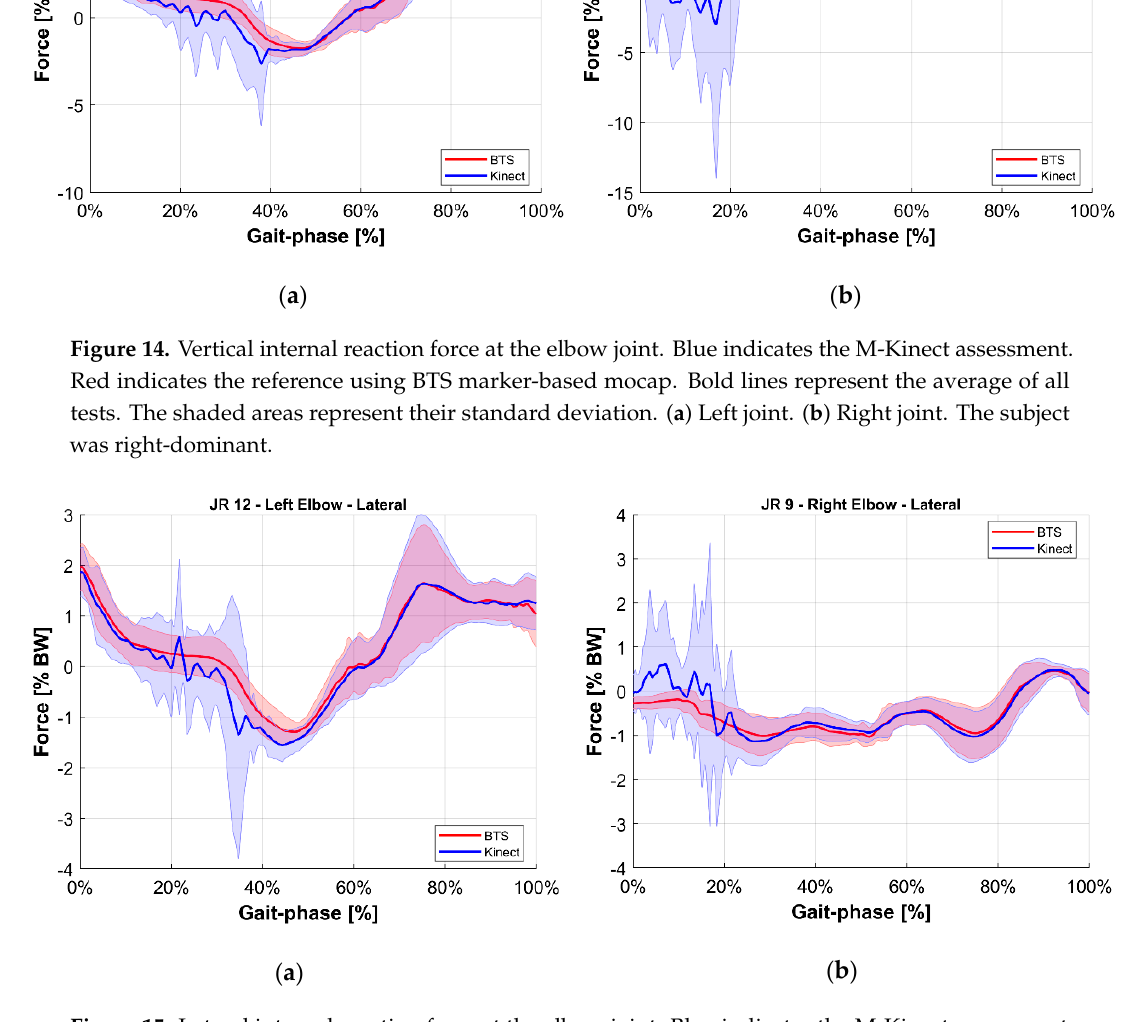
Figure 15. Lateral internal reaction force at the elbow joint. Blue indicates the M-Kinect assessment. Red indicates the reference using BTS marker-based mocap. Bold lines represent the average of all tests. The shaded areas represent their standard deviation. ( a ) Left joint. ( b ) Right joint. The subject was right-dominant.